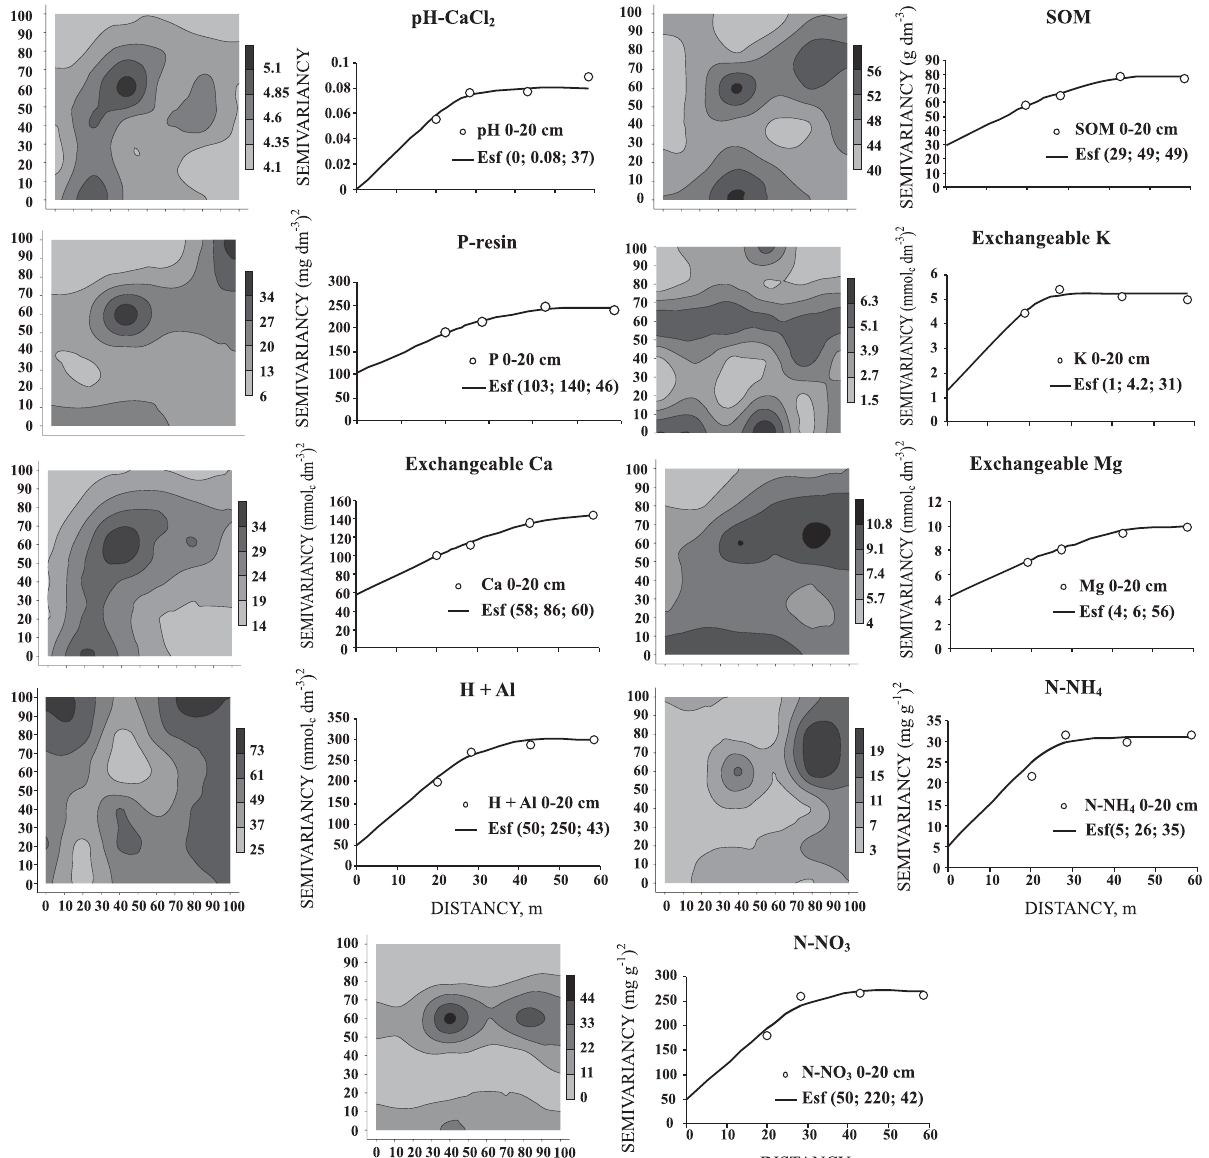
Figure 4. Spatial variability maps and semivariograms of soil chemical properties in the 0–0.2 m layer. (Modelo; C ; C ; 0 1